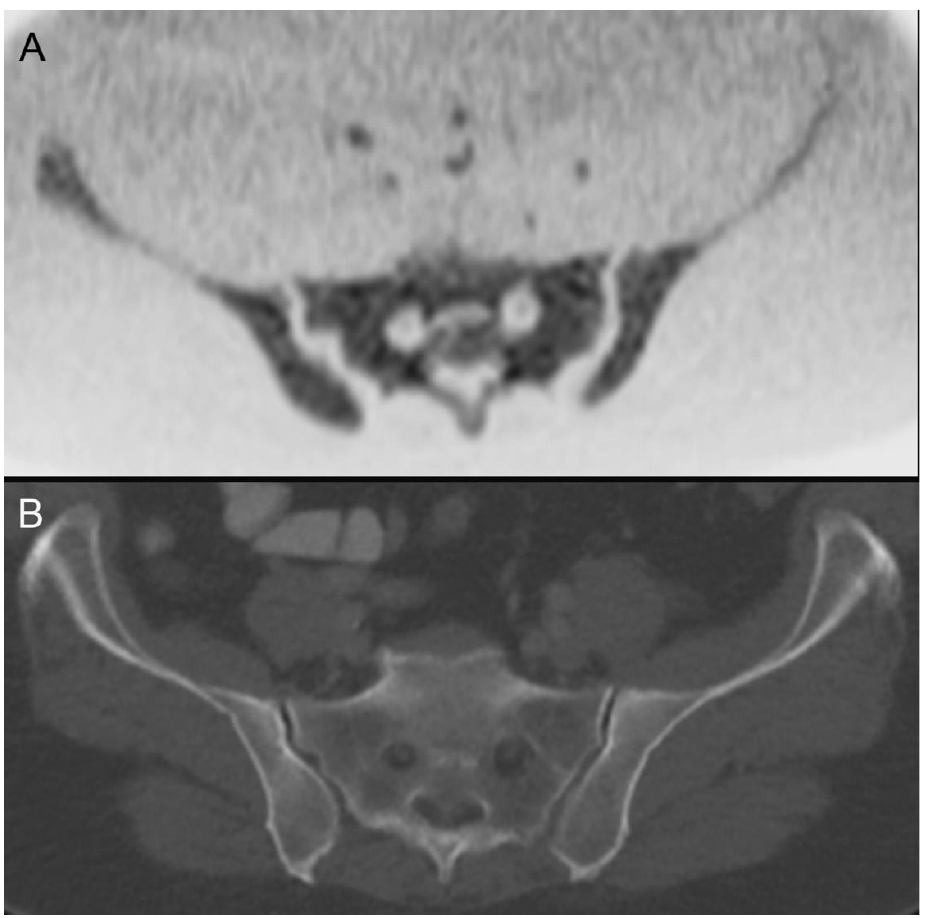
Figure 5. DWIBS ( A ) contrary to contrast-enhanced abdominal CT ( B ) reveals diffuse diffusion restriction of the bone marrow with no abnormalities in CT, which lead to the diagnosis of acute myeloid leukemia after further clinical work-up in this 76-year-old female patient.